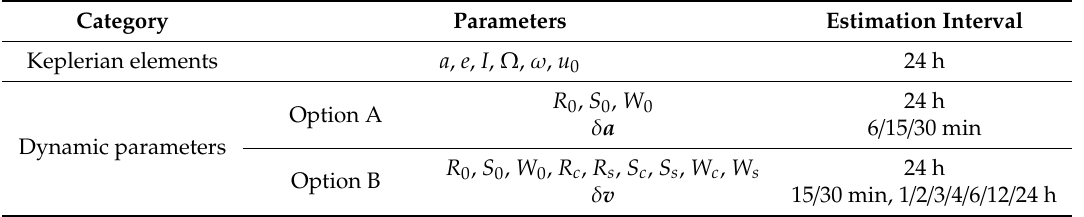
Table 2. Options for estimable parameters for orbit estimation and